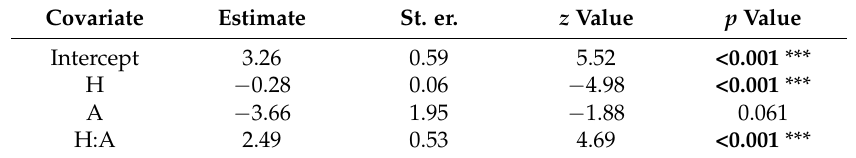
Table 2. Model statistics for the general linear mixed model of the binary response variable survival.